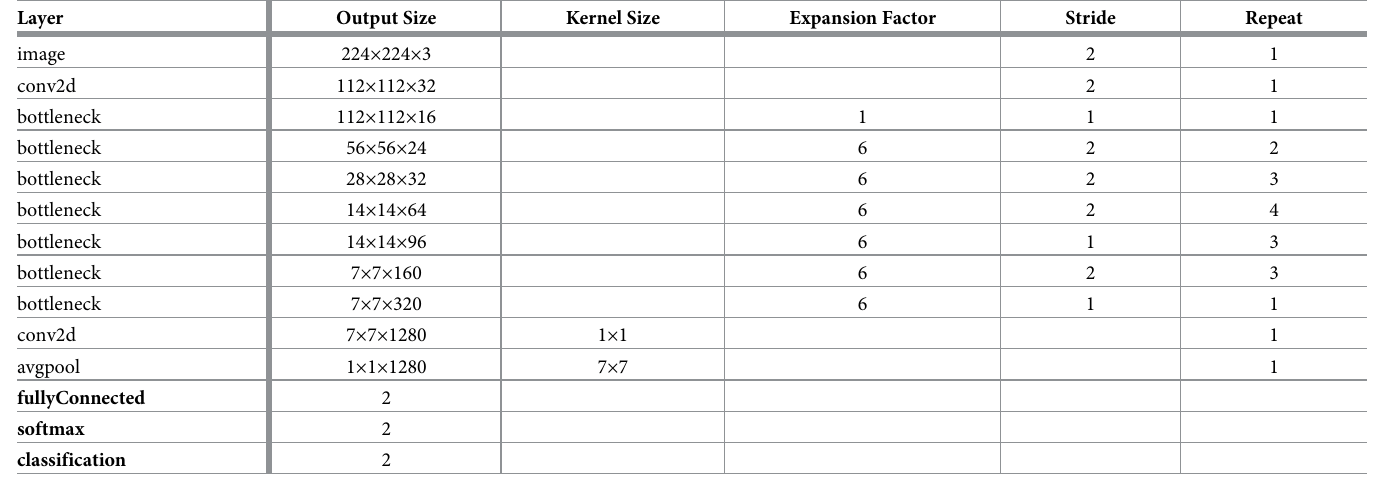
Table 3. MobileNetv2